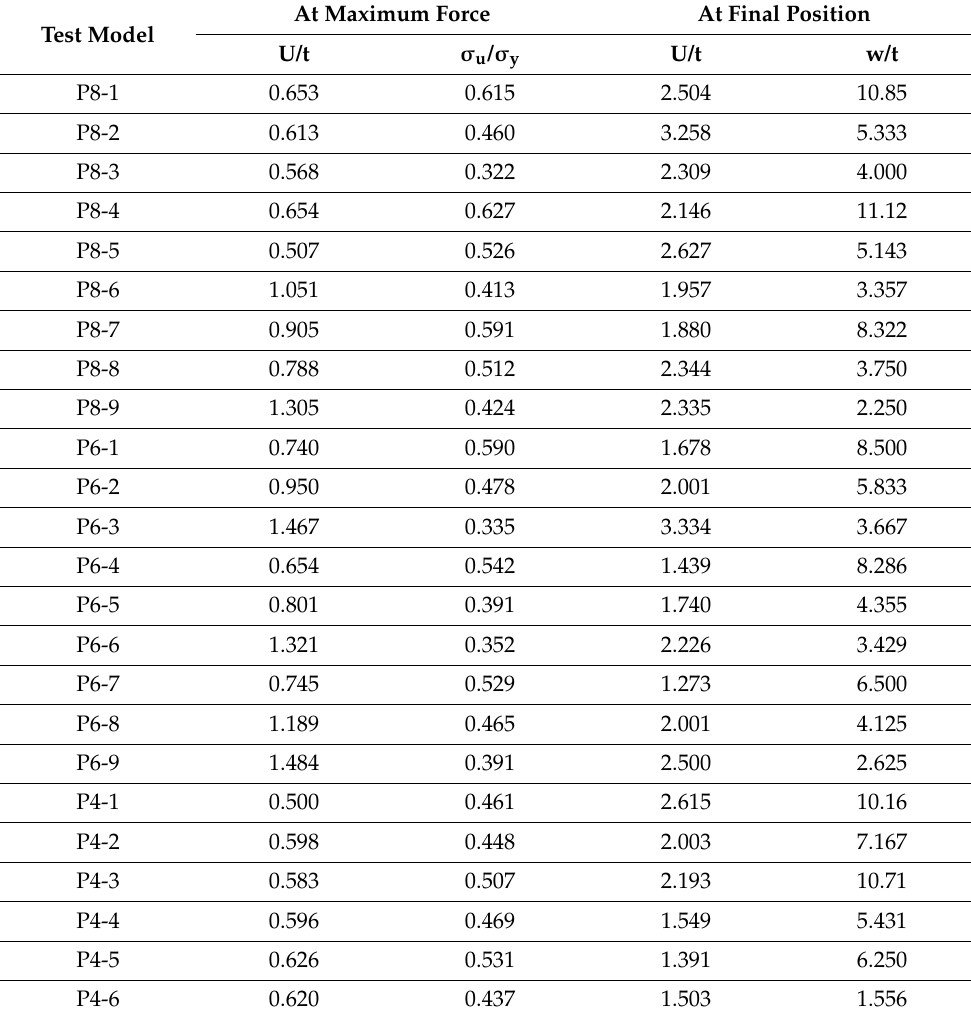
Table 4. Result of the buckling